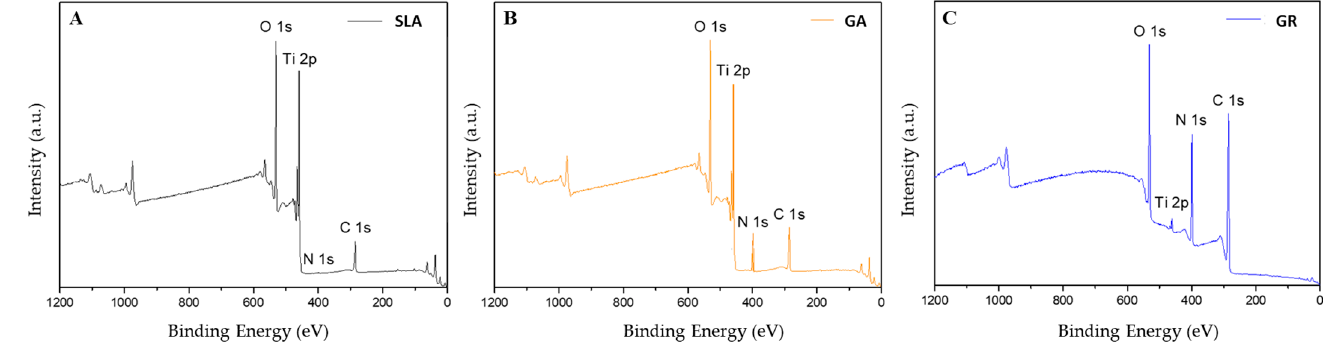
Figure 4. The scanning electron microscopy (SEM) images. ( A ) The SLA (Sandblasted, large grit, acid-etched implant sur- face) group, ( B ) The GA (glutaraldehyde) group, and ( C ) the GR (gamma-radiation) group. [Original magnifications: ×40, ×5000, and ×50,000].